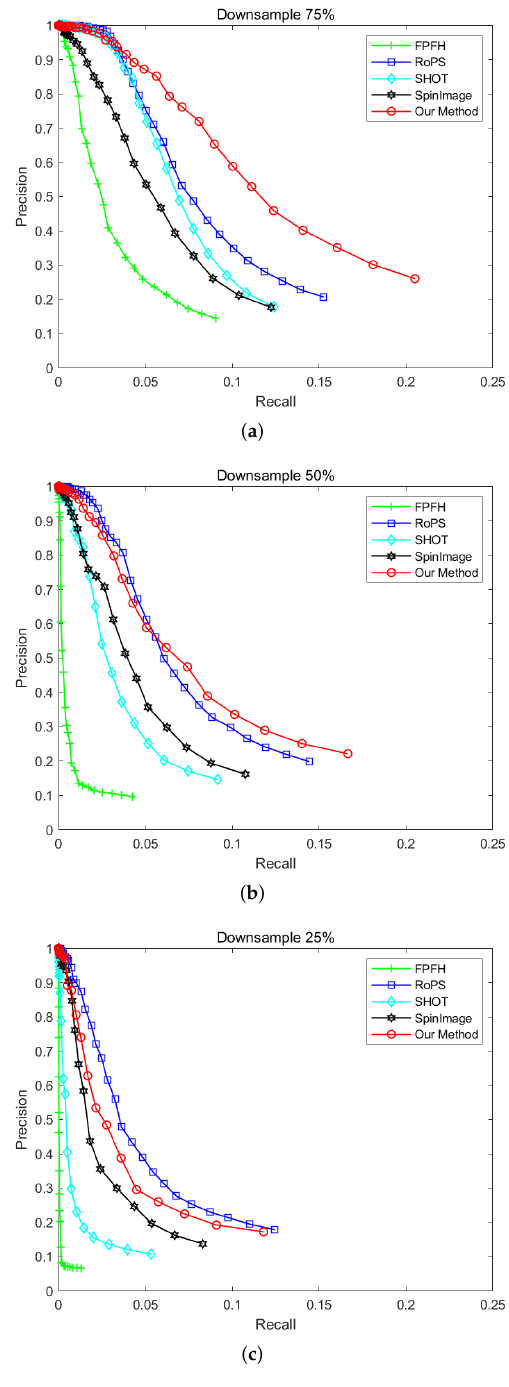
Figure 11. P-R curves in different mesh resolution. ( a ) Downsampling 75%. ( b ) Downsampling 50%. ( c ) Downsampling